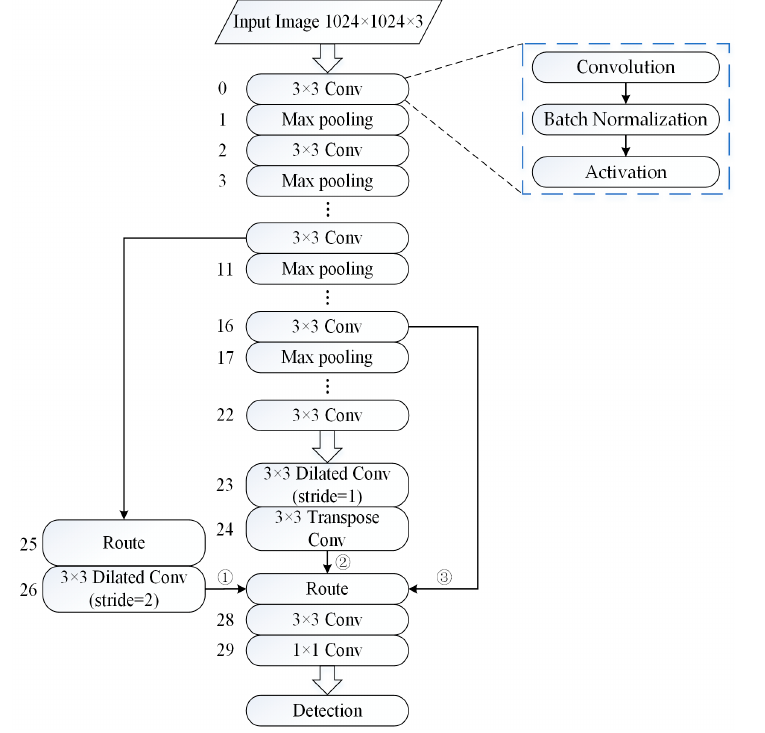
Figure 1. The structure of the improved YOLOv2. Each convolutional layer contains not only convolution but also batch normalization and activation sublayers.